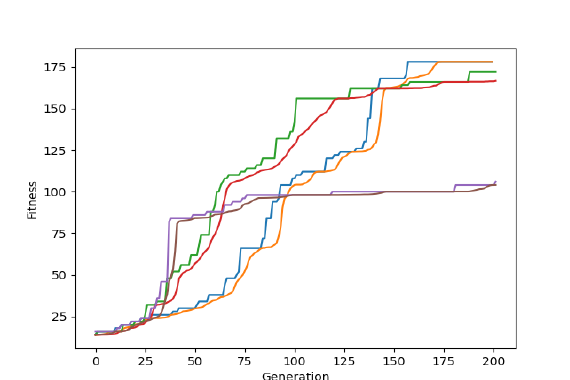
Figure 2. Best population fitness rate with chromosomes of length 30, 50,